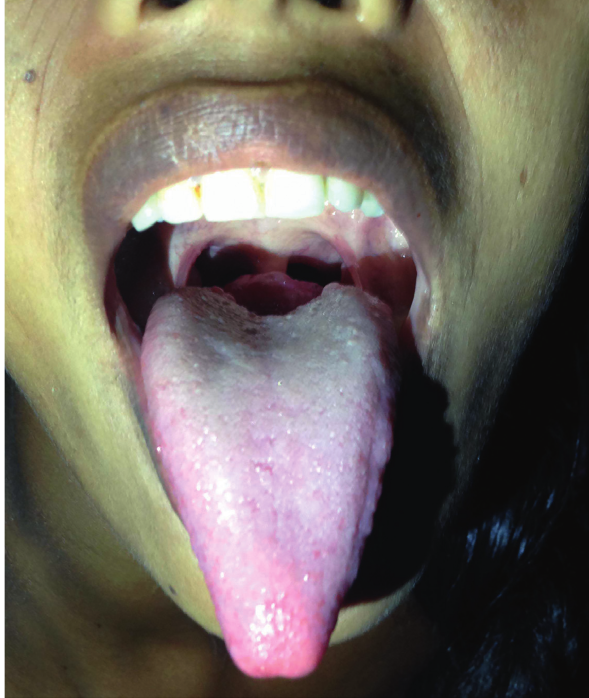
Figure 1: Throat examination showing midline nodule in the base of the